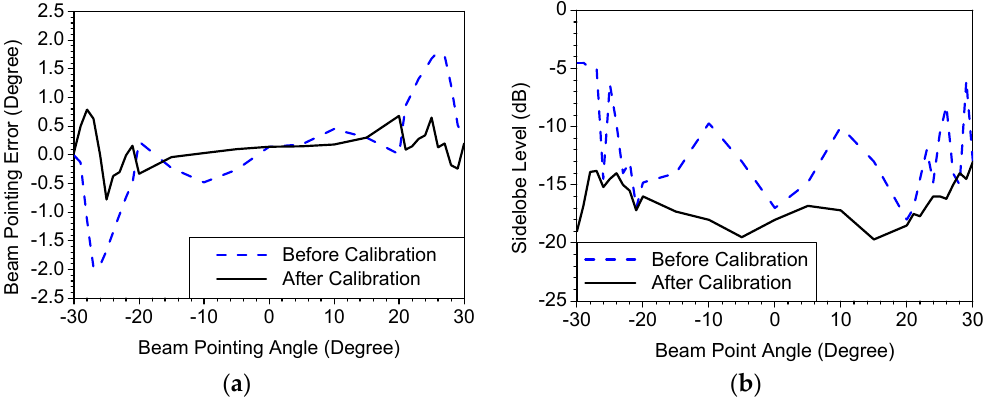
Figure 14. Antenna performances with and without pattern calibrations: ( a ) beam pointing error and ( b ) sidelobe level.